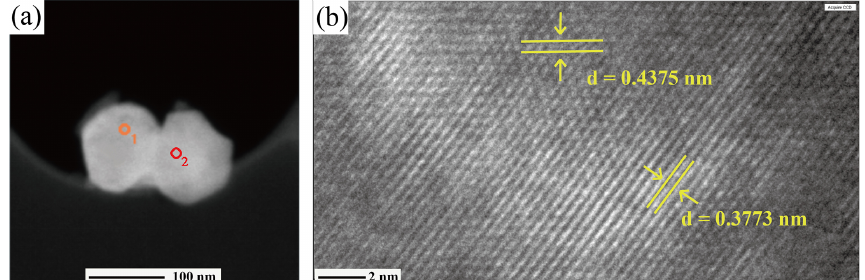
Figure 9. TEM images of liguowuite. (a) High-angle annular dark field (HAADF) image of the analyzed nanocrystals. The selected electron diffraction results for the circle 1 and circle 2 regions are shown in Fig. 10a and b, respectively. (b) The HRTEM image of the right particle in Fig. 9a, with lattice fringe spacings of 0.3773 and 0.4375nm corresponding to the { 020 } and { 111 } planes,